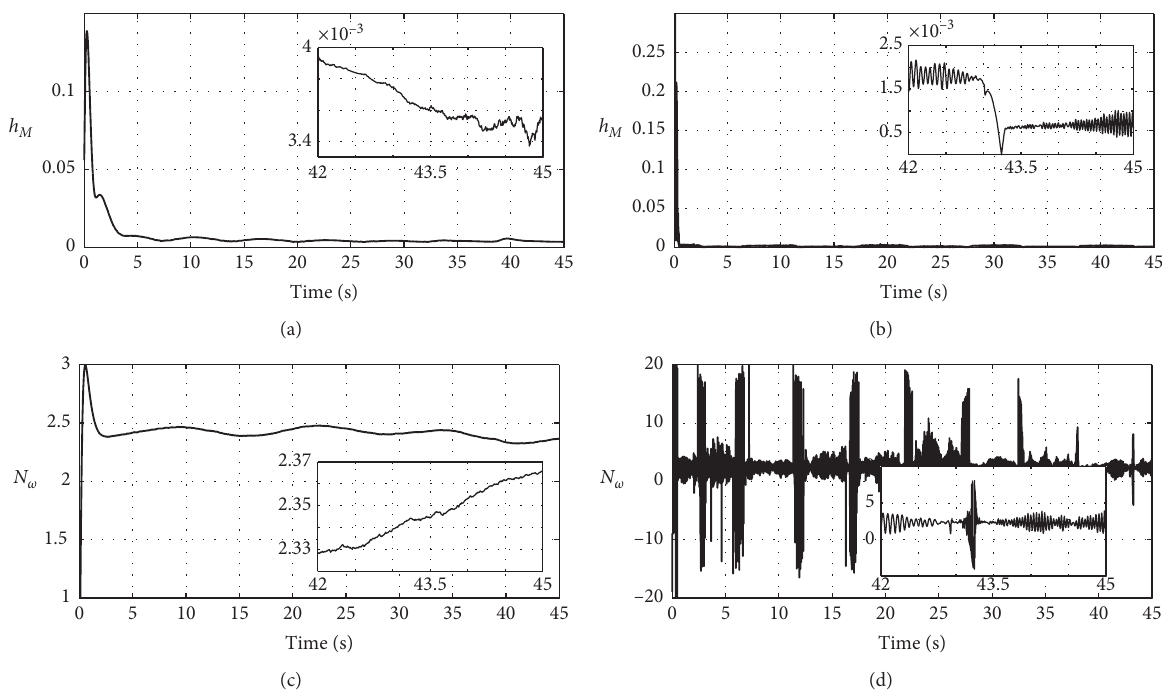
Figure 5: Comparison between the control strategies OCS and TBS, when the system is perturbed by a normally distributed random process with zero mean: (a) OCS error index; (b) TBS error index; (c) OCS control action; (d) TBS control